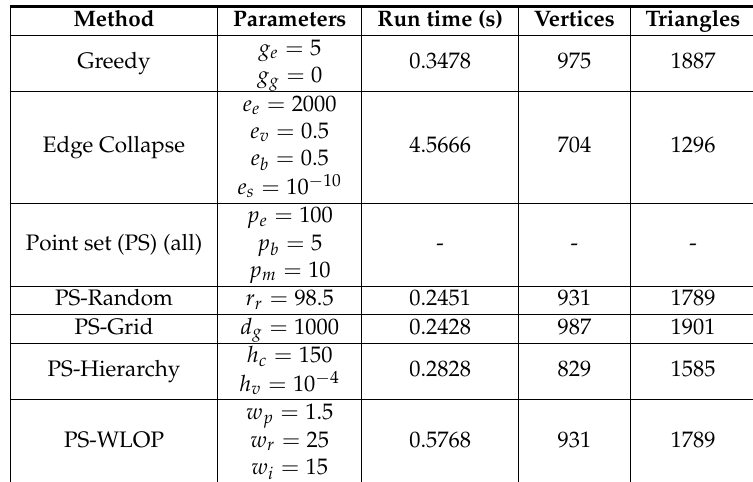
Table 2. Parameters, run times, and resulting vertices and triangles for the experiments described in Section